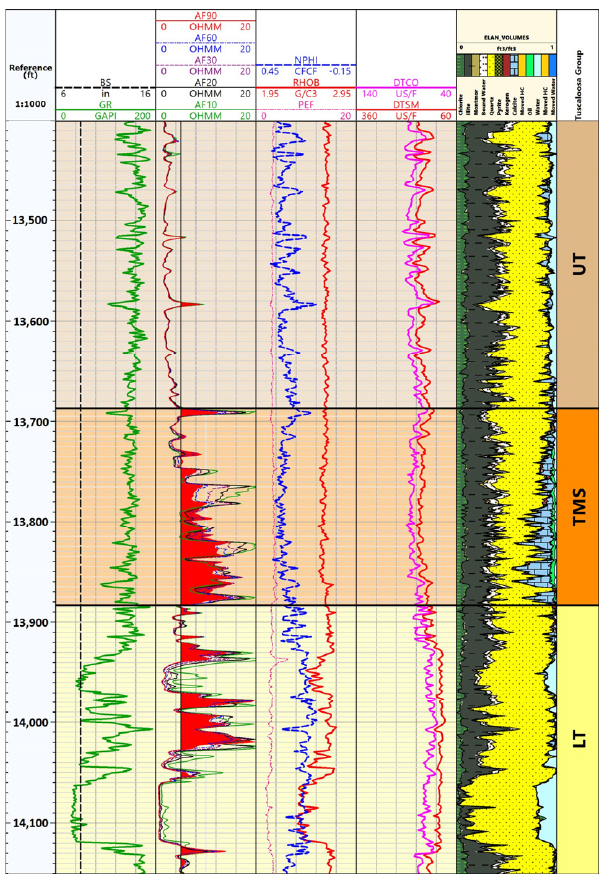
Figure 2. Type log of the Tuscaloosa Marine Shale in a well in the East Feliciana Parish, LA. For a quantitative formation evaluation with respect to lithology and fluids saturation, a petrophysical model with M components representing both solid and fluid